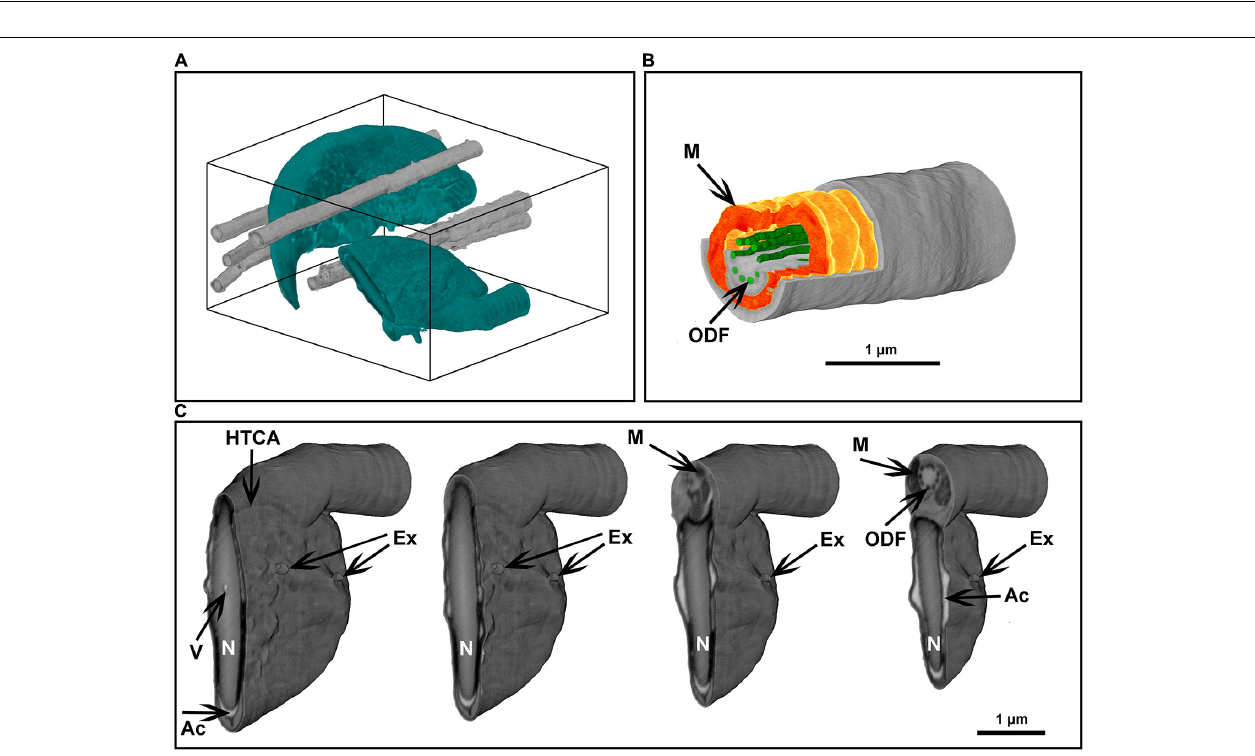
FIGURE 8 | Focused ion beam scanning electron microscope tomography of a monolayer of mouse sperm. (A) Volume reconstruction 4.25 × 3.3 × 4.9 µ m. Sperm head (green) and flagella (gray). (B) Segmented fragment of the mid-piece. (C) Virtual cross-sections (step 500 nm) of the head area. Ex, exosome-like structures attached to the plasma membrane; HTCA, head-tail-coupling apparatus; Ac, acrosome; M, mitochondria; N, highly condensed DNA within the nucleus; ODF, outer dense fibers; V, a potential nuclear vacuole. The figures are presented in orthographic projection.